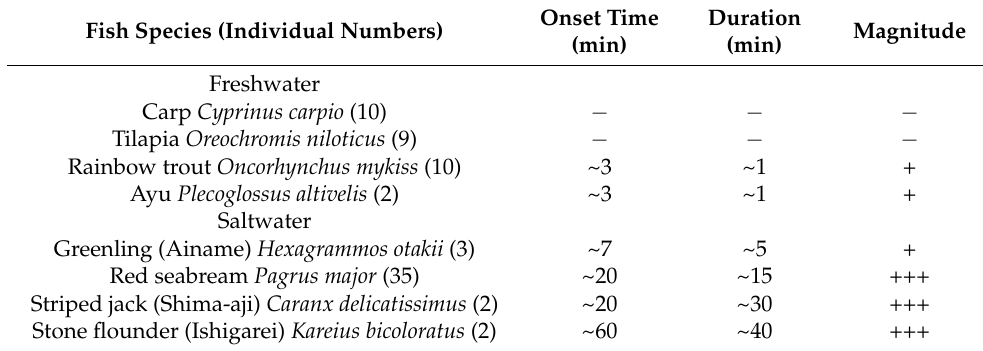
Table 1. Delayed convulsion profiles of different fish species. Delayed convulsion components were registered immediately after sacrifice by